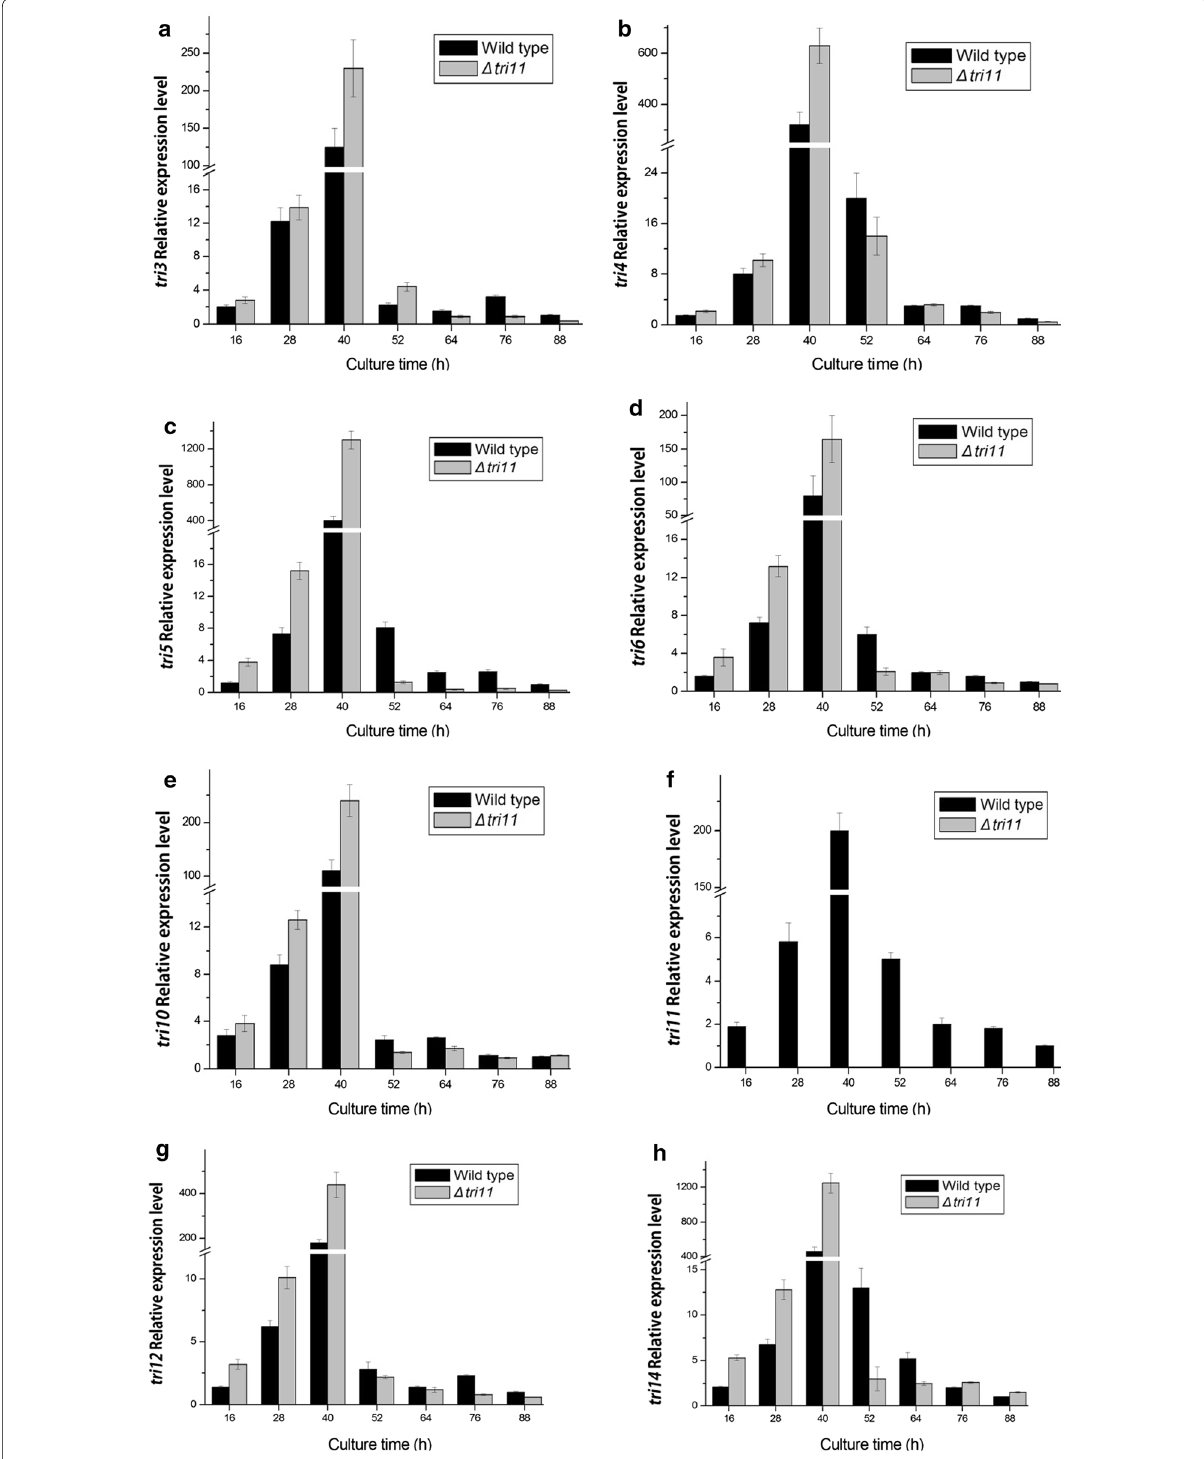
Fig. 5 Expression of tri genes in Δ tri11 mutant and wild strain. The quantification of tri11 gene expression in the different culture times was ana- lyzed by 2 − ΔΔCt method. The wild strain cultured for 88 h was used as control and β - tubulin as reference gene. a tri3 , b tri4 , c tri5 , d tri6 , e tri10 , f tri11 , g tri12 , and h